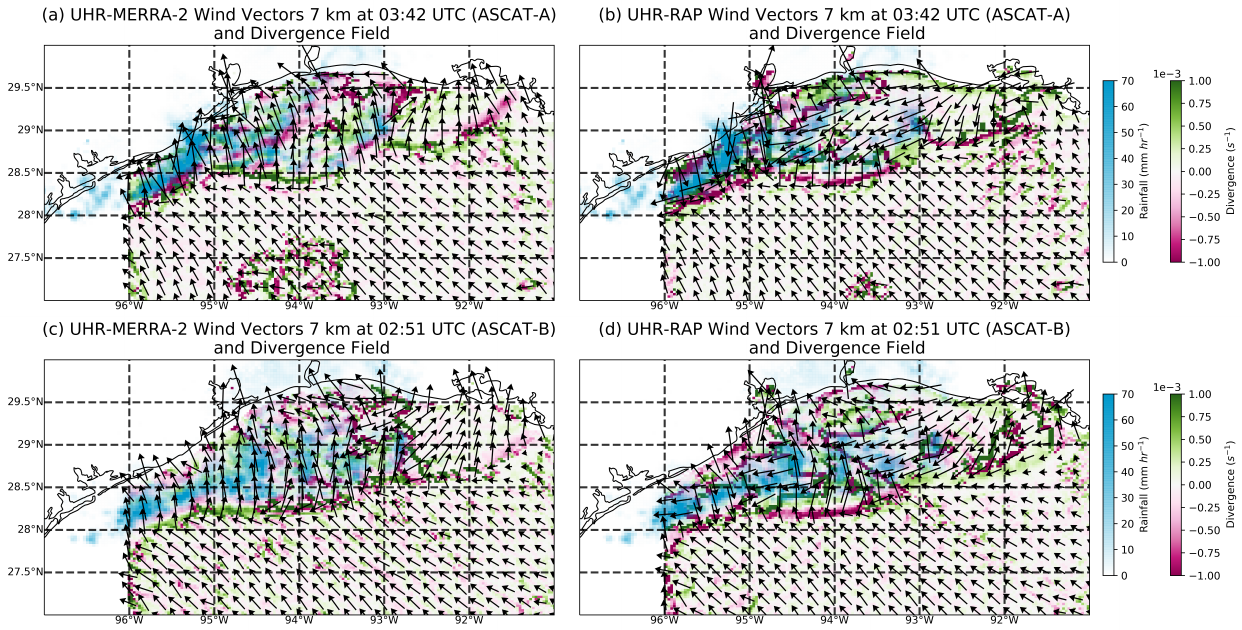
Figure 8. UHR wind vectors are depicted in black and divergence field in green and dark pink for ( a ) MERRA-2 and ( b ) RAP background winds at 02:51 UTC (ASCAT-A) on 28 May 2016. Similarly, ( c ) MERRA-2 and ( d ) RAP background winds at 03:42 UTC (ASCAT-B). KHGX rainfall rate is depicted in light blue filled contours and reported at 02:57 UTC for ASCAT-A and 03:46 UTC for